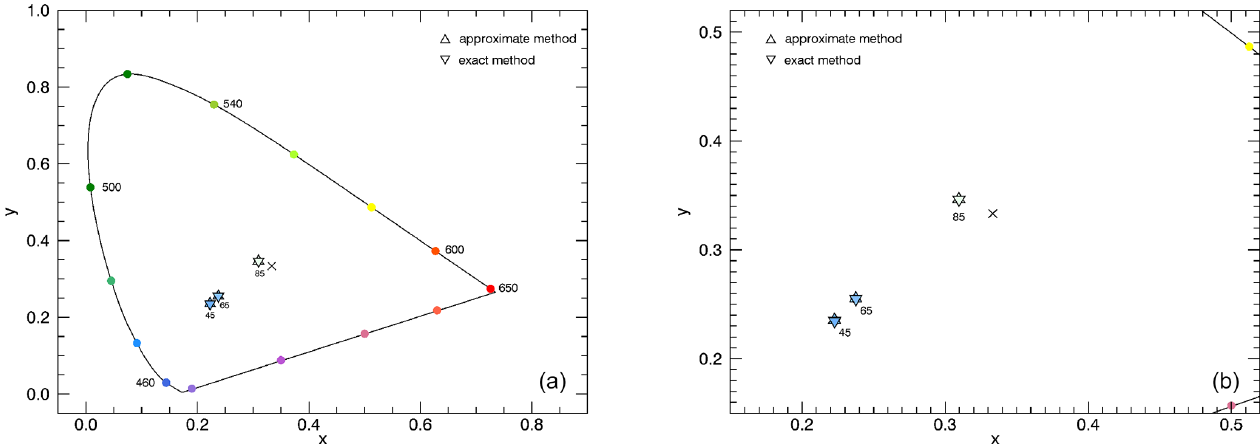
Figure 13. CIE chromaticity diagram for simulations with NLCs considering different methods for treating multiple scattering. Marked at the data points are the following: VZAs = 45, 65 and 85 ◦ , with SZA = 98 ◦ and SAA = 0 ◦ . The NLC parameters are the following: r m = 50nm, S = 1 . 4, τ NLC = 10 − 4 and z NLC = 82km. Panel (b) shows an enlarged